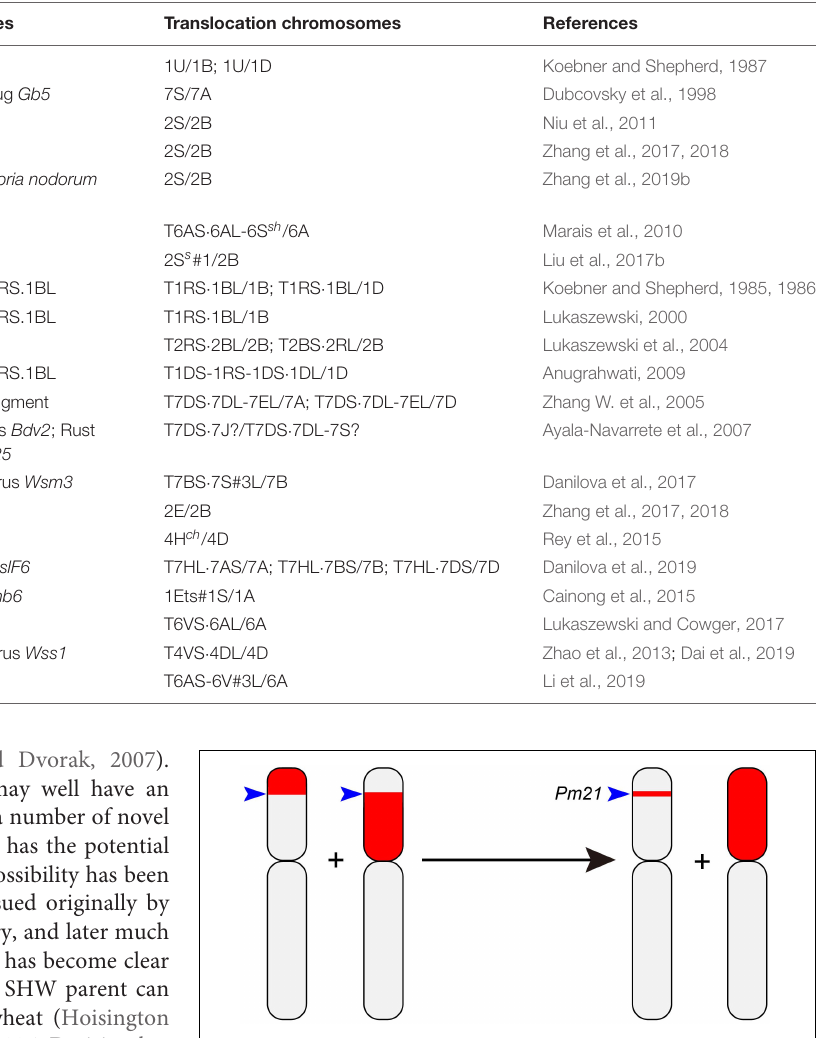
TABLE 2 | Examples of small translocations generated by manipulation with ph1b .